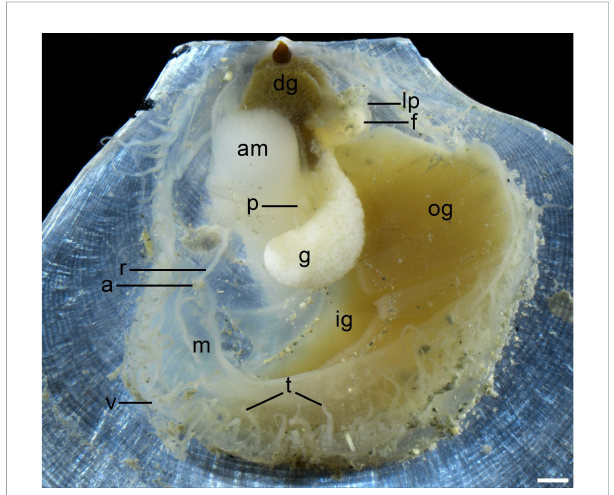
FIGURE 4 Anatomy features of Catillopecten margaritatus n. sp. of the paratype 1 (TMBC, SCSMBC031007) left valve. Abbreviations: a, anus; am, adductor muscle; dg, digestive gland; f, foot; g, gonad; ig, inner